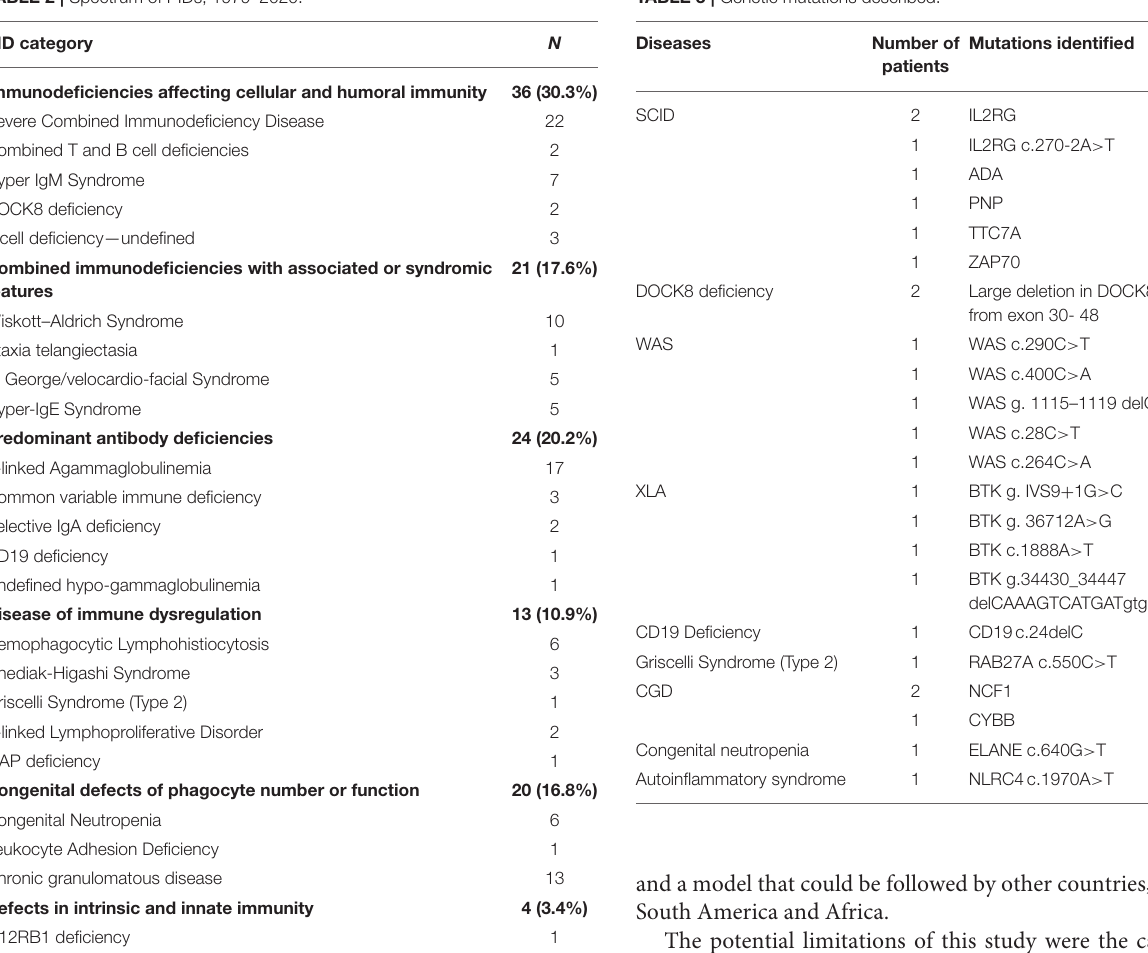
TABLE 3 | Genetic mutations